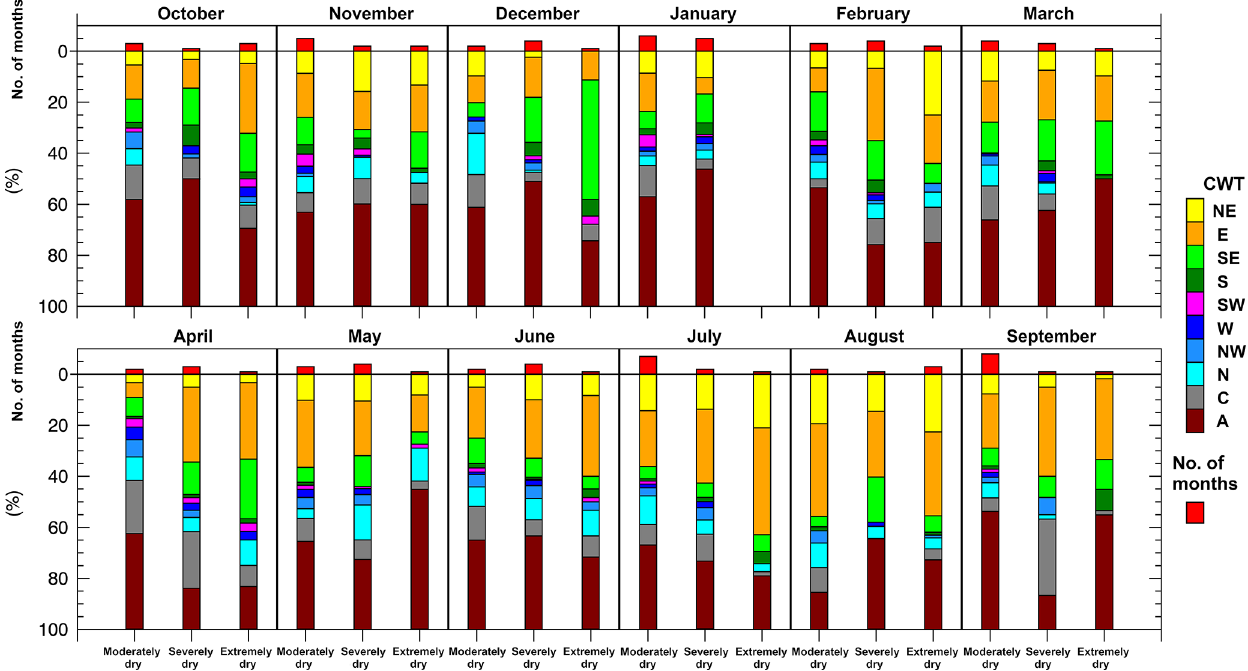
Figure 11. Monthly percentage of occurrence for every CWT associated with moderately, severely, and extremely dry conditions. The red bars represent the number of months the MLSHD was affected by each drought